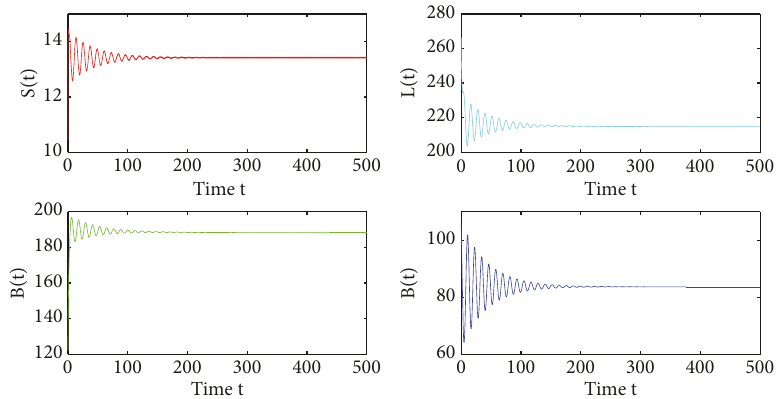
Figure 1: Time plots of 𝑆 , 𝐿 , 𝐵 , and 𝑅 with 𝜏 = 3.2575 < 𝜏 0 = 3.4685 .